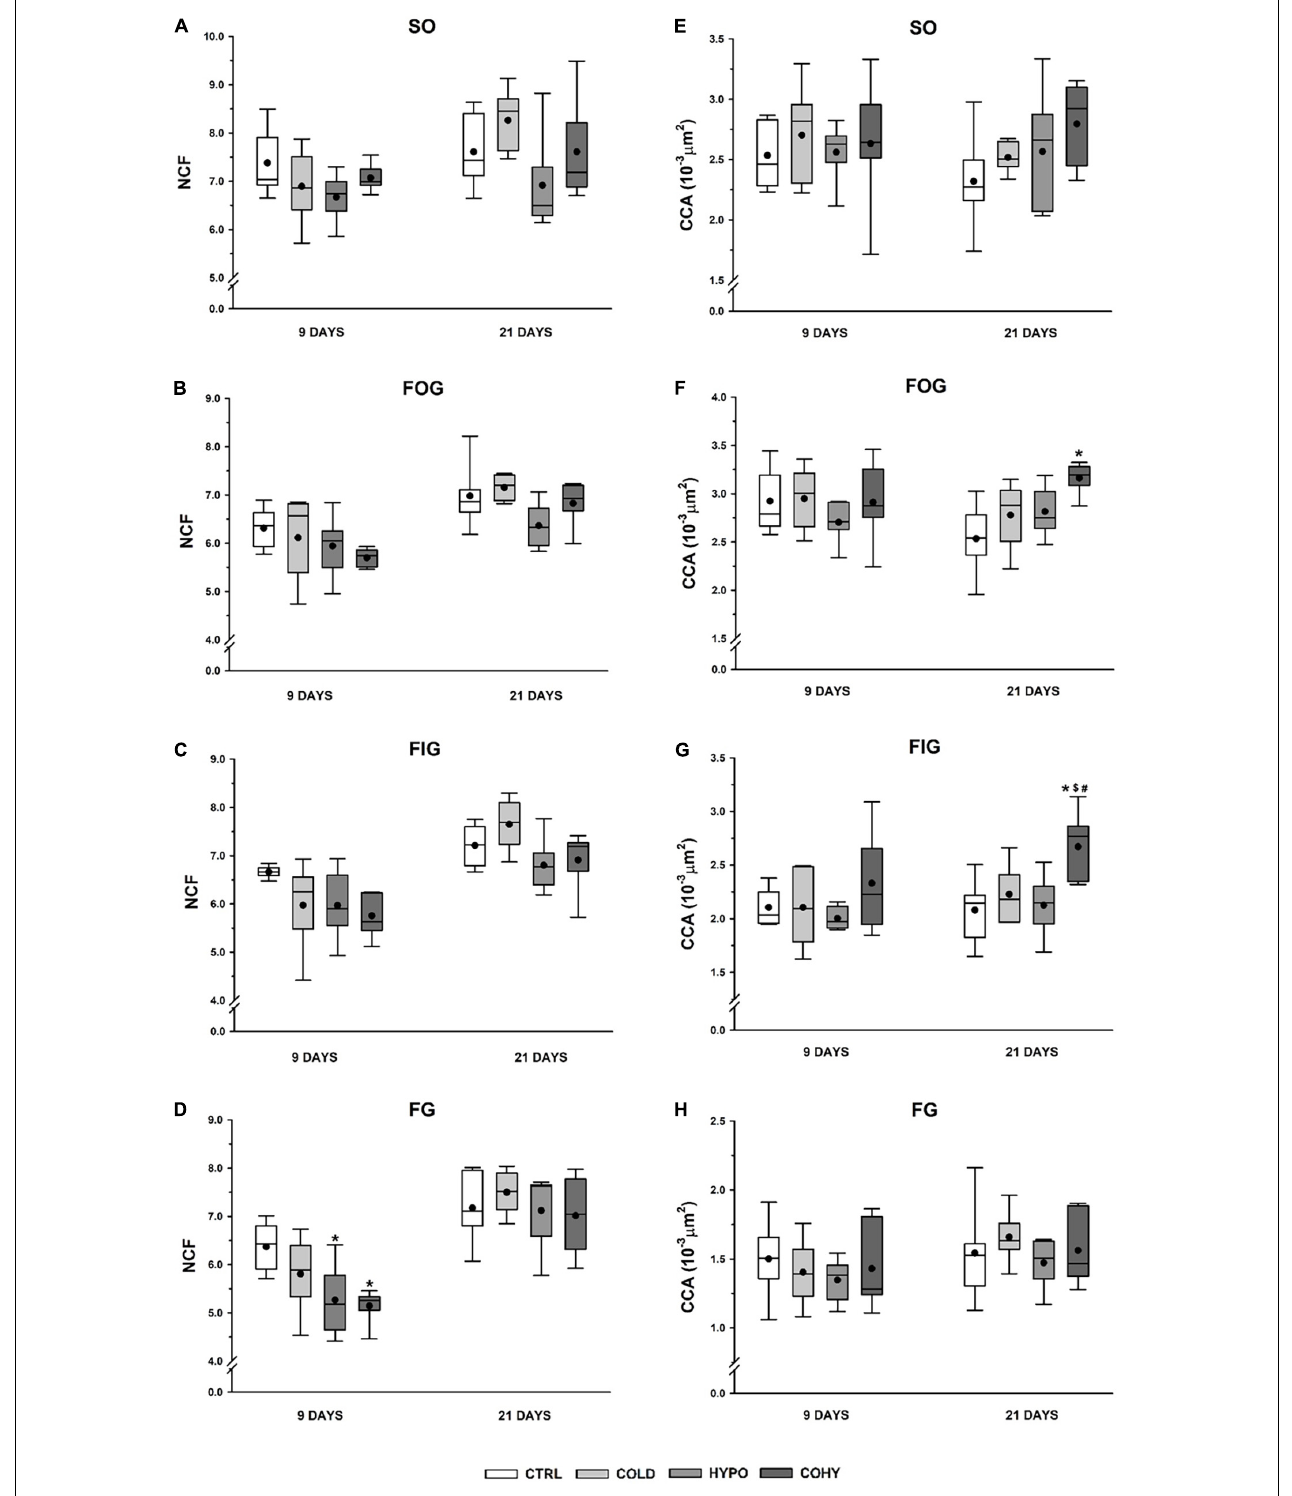
FIGURE 5 | Gastrocnemius individual fiber capillarization after 9 and 21 days in the different fiber types. (A–D) Number of capillaries per fiber (NCF), (E–H) fiber capillarization index (CCA). SO, slow oxidative; FOG, fast oxidative glycolytic; FIG, fast intermediate glycolytic; FG, fast glycolytic. CTRL, control; COLD, intermittent cold; HYPO, intermittent hypoxia; COHY, intermittent cold + hypoxia. Statistically significant differences are indicated as follows: * p < 0.05 vs. CTRL, # p < 0.05 vs. COLD, $ p < 0.05 vs. HYPO. Sample size: n = 6 per group at each temporal time point.